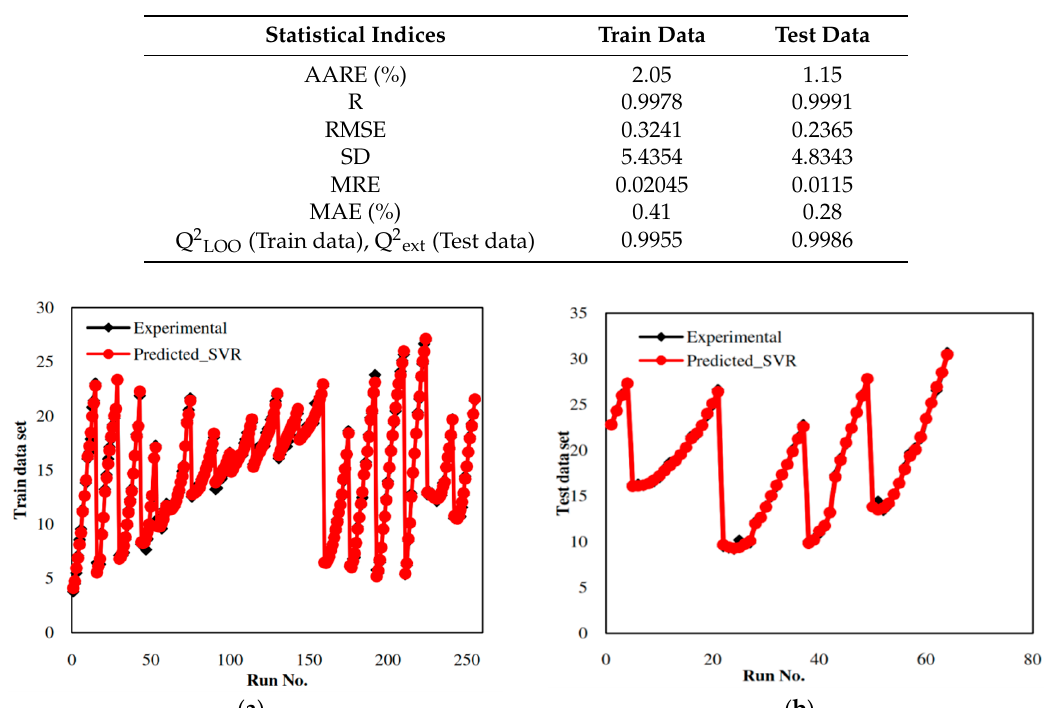
Figure 4. ( a ) Training course curve for the heat transfer coefficient. ( b ) Test course curve for the heat transfer coefficient .